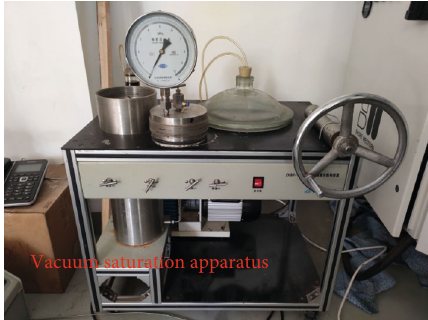
Figure 3: The vacuum saturation apparatus for the pre fl awed